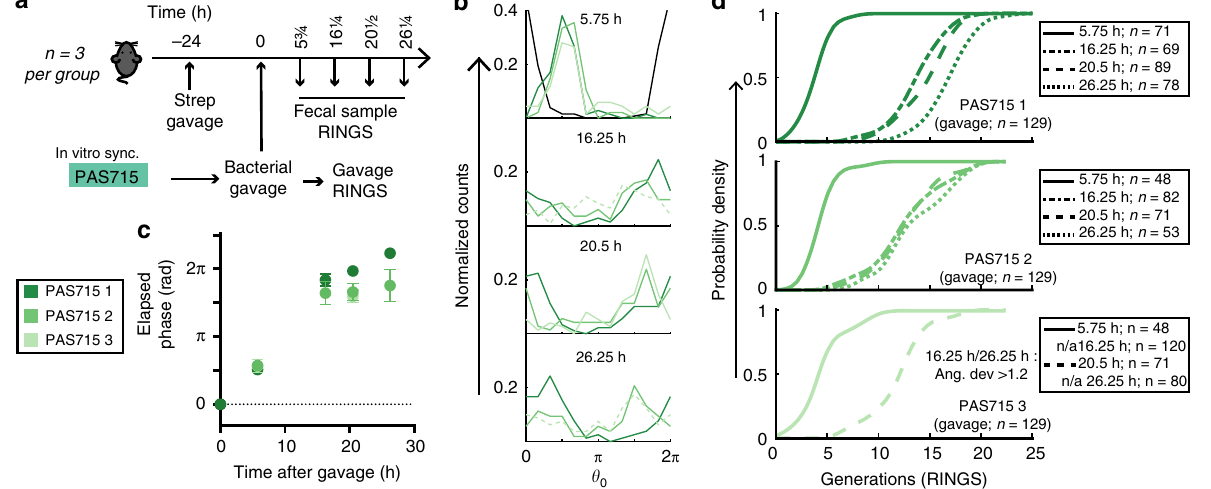
Fig. 4 The repressilator 2.0 is robust and informative within the mouse gut. a in vitro synchronized PAS715 ( E. coli ) bacteria measure growth in mice treated with a single dose of streptomycin ( n = 3 per group). b Histograms of bacterial phase distributions throughout the experiment. Graphs show normalized counts. 5.75h timepoint is compared to the gavage population (black line). Dotted lines represent datasets with angular deviation >1.2, which were excluded from downstream analyses. For number of colonies analyzed at each timepoint, see corresponding data in d . c Graph of average elapsed phase of the population vs time for each mouse. Graph shows mean with 95% CI. d Cumulative distribution functions of predicted generations elapsed since gavage. Source data are provided as a Source Data fi con fi dent assignment of elapsed growth from RINGS phase data (Supplementary Fig. 6). As expected, RINGS analysis estimated that growth was most rapid immediately following gavage and slowed considerably in later timepoints (Fig. 4c, Supplementary Fig. 5d, i), with similar average growth predicted for both species (PAS715: 12.2 – 15.1 gen and PAS716: 13.0 – 15.1 gen at 20.5 h post gavage). These dynamics were further con fi rmed by Peak-to- Trough Ratio (PTR) analysis, which estimates the average instantaneous growth rate of a population from metagenomic sequencing data (6 h: 1.72 ± 0.08, n = 4; >16 h: 1.44 ± 0.08, n = 9; Supplementary Table 2) 15 . Together these data demonstrate the ability for RINGS to detect changing growth within the mouse gut.